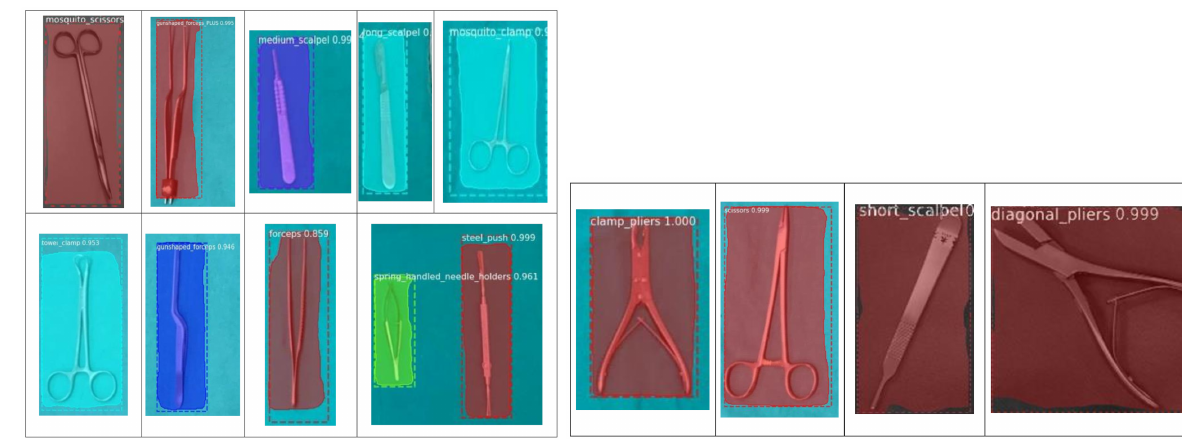
Figure 8. Some examples of correct results by the trained Mask RCNN network.